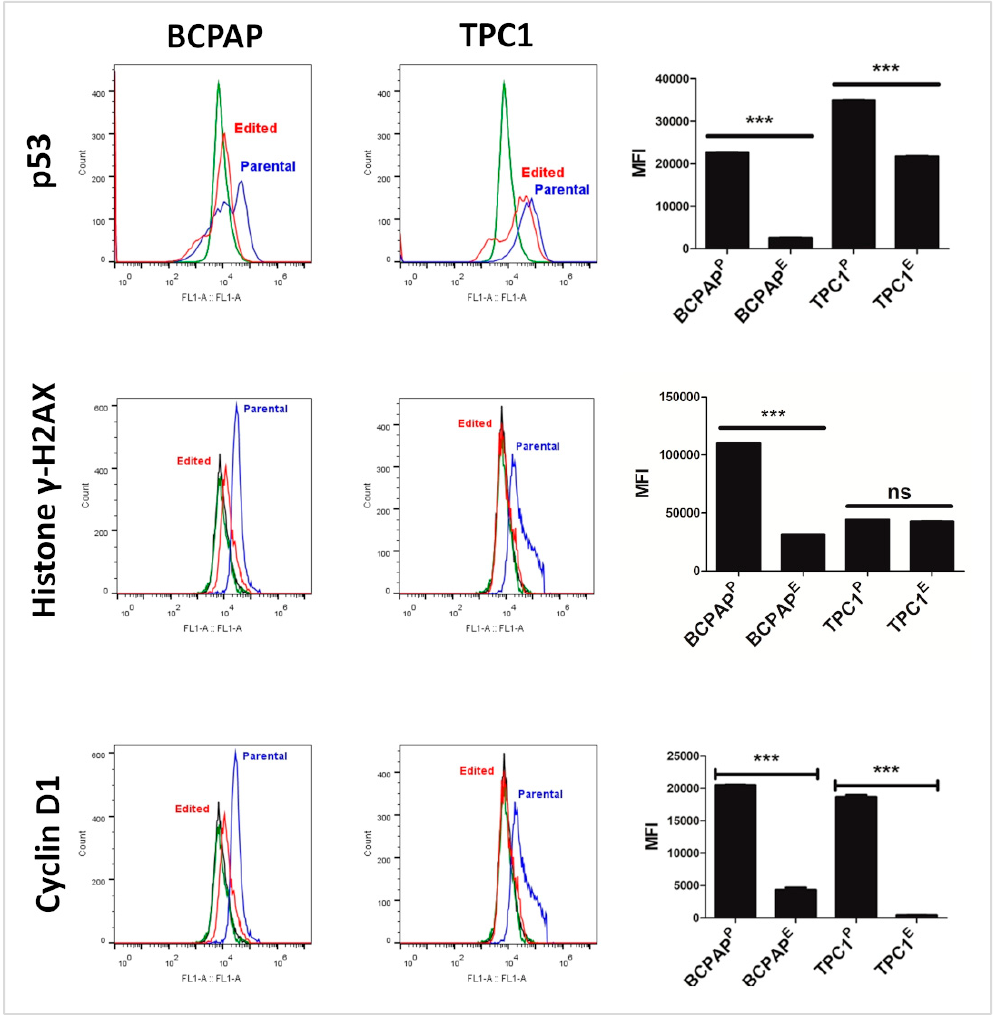
Figure 10. Results of immunodetection of p53, histone γ -H2AX, and cyclin D1 by flow cytometry. Results show a significant downregulation of all analyzed proteins in both edited cells. Flow cytometry analyses show cells not incubated with primary and secondary antibodies (histogram in black), cells exclusively incubated with secondary antibody (histogram in green), and cells incubated with both primary and secondary antibodies (histogram in red). There were 10,000 events analyzed in duplicate. *** p < 0.001, non-significant statistical difference (ns).